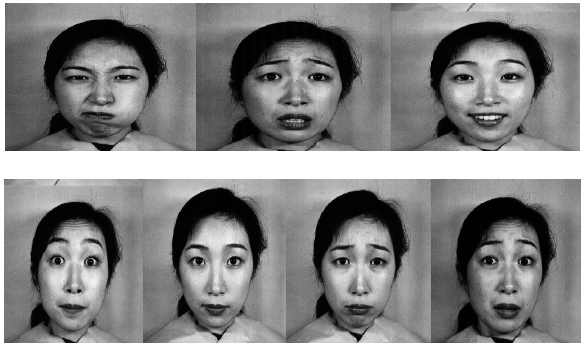
Figure 8. Partial image from the ORL database.